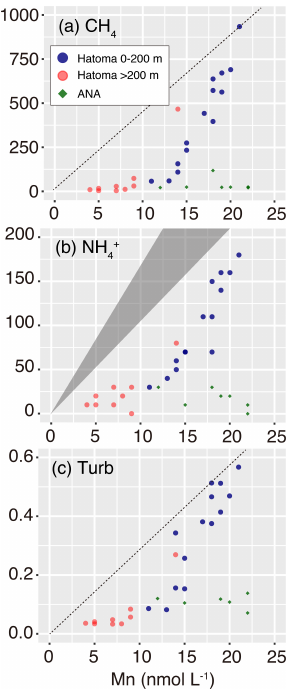
Figure 6. Manganese plots with CH 4 concentration, ammonium concentration, and turbidity. Symbols are the same as those in Fig. 3. The grey triangle in (b) represents the ideal mixing line be- tween ambient seawater and the Hatoma vent fluid having NH 4 / Mn ratios of 11–18. Diagonal dotted lines in (a) and (c) represent esti- mated mixing lines between ambient seawater and the hydrothermal plume source, assumed by the highest CH 4 / Mn and turbidity / Mn ratios